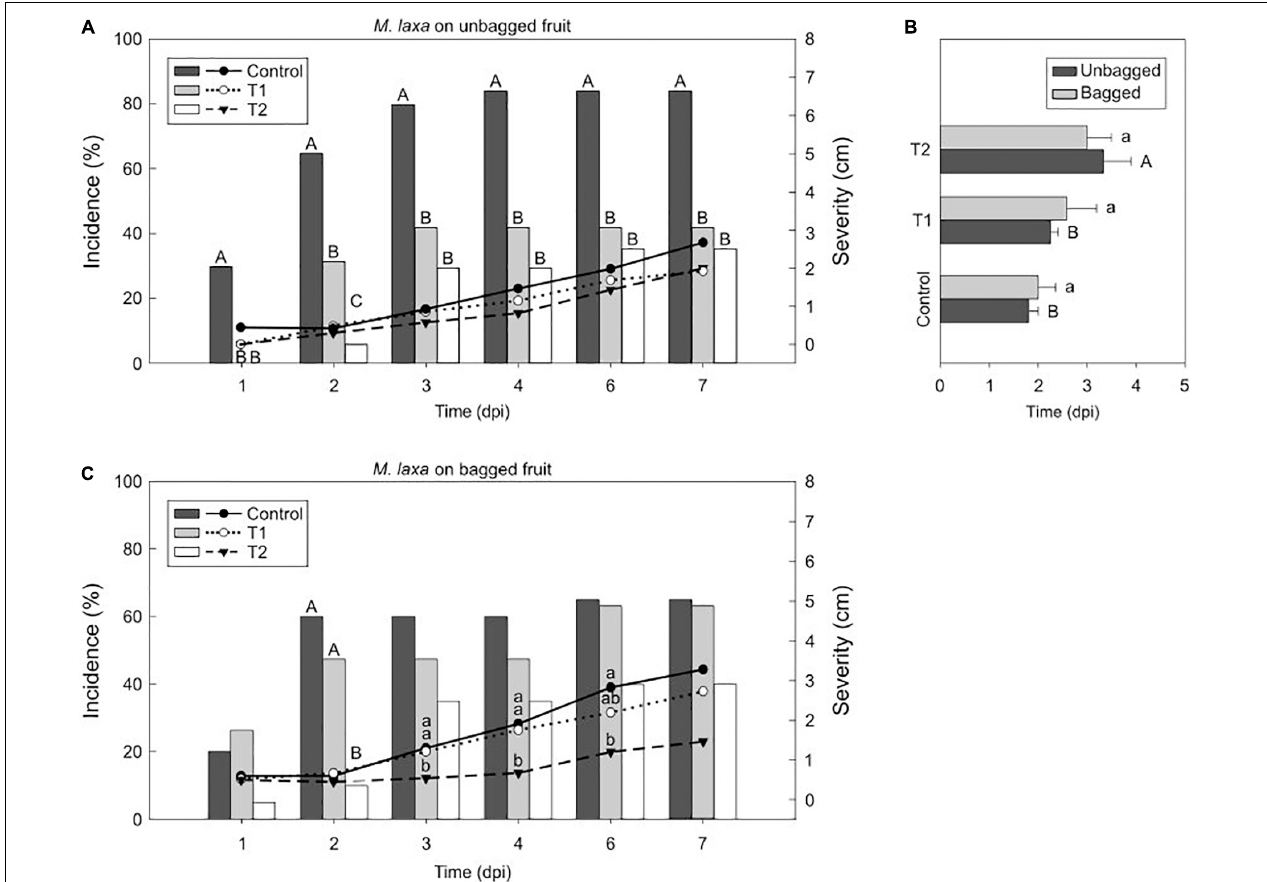
FIGURE 3 | Light effect on the M. laxa -nectarine interaction. Incidence (% of brown rot, bars) and severity (lesion diameter length in cm of rotted fruit, lines) of M. laxa in unbagged (A) and bagged (C) “Fantasia” nectarines along the infection time course (dpi, days post-inoculation) incubated for 7 days under treatments 1 and 2 and control condition (constant darkness). Bars represent the mean of incidence on fruits ( n = 20). Lines represent the mean of diameter length of rotted fruit. Different uppercase and lowercase letters indicate significant differences ( P ≤ 0.05) of incidence and severity, respectively, among incubation conditions according to orthogonal contrasts at each time point. No letters indicate no significant differences. The incubation period (dpi) of M. laxa in bagged and unbagged “Fantasia” nectarines (B) after 7 days of incubation under treatments 1 and 2 and control condition. Bars represent the mean of fruits with symptoms ( n = 2 to 20) and error bars represent the standard error of the means. Different uppercase and lowercase letters indicate significant differences ( P ≤ 0.05) among incubation conditions in unbagged and bagged fruit, respectively, according to orthogonal